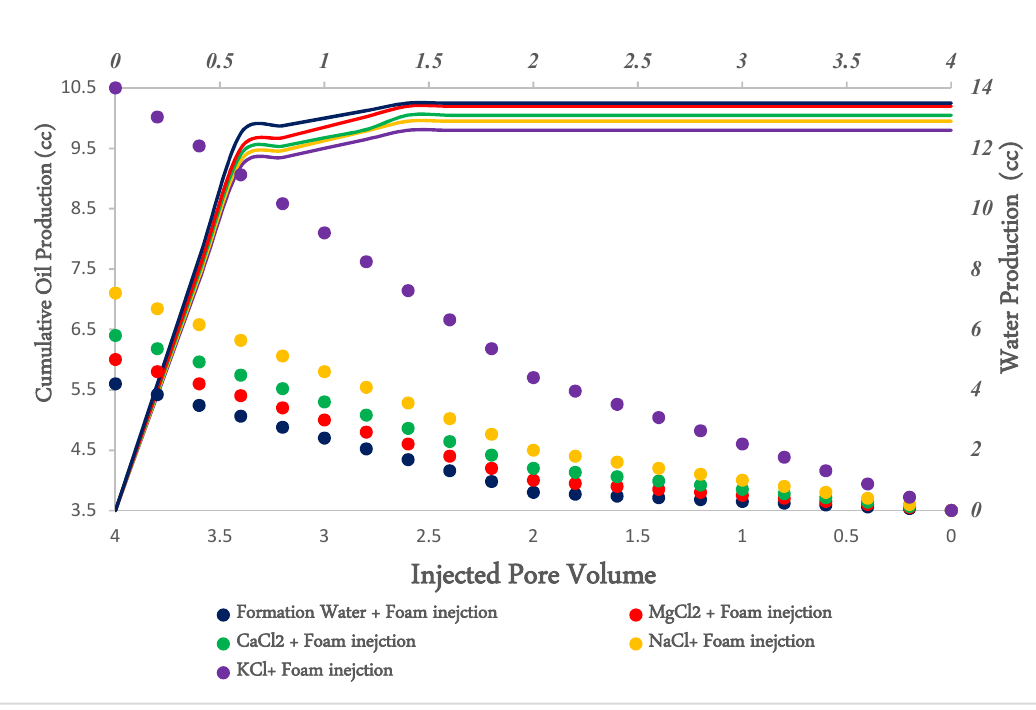
Table 2. Summary of results.